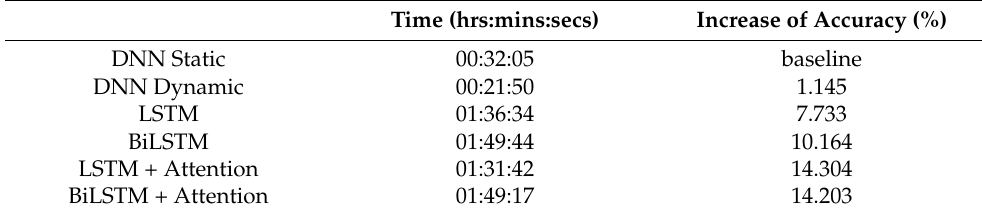
Table 5. Model average training time from ten runs vs. increase of accuracy. Time (hrs:mins:secs) Increase of Accuracy